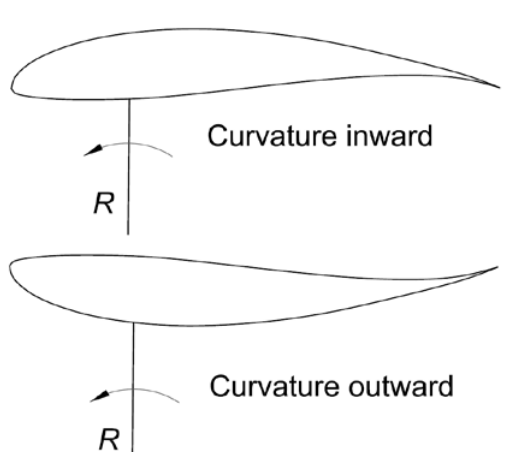
Figure 7. Airfoil curvature (camber) oriented radially inward and